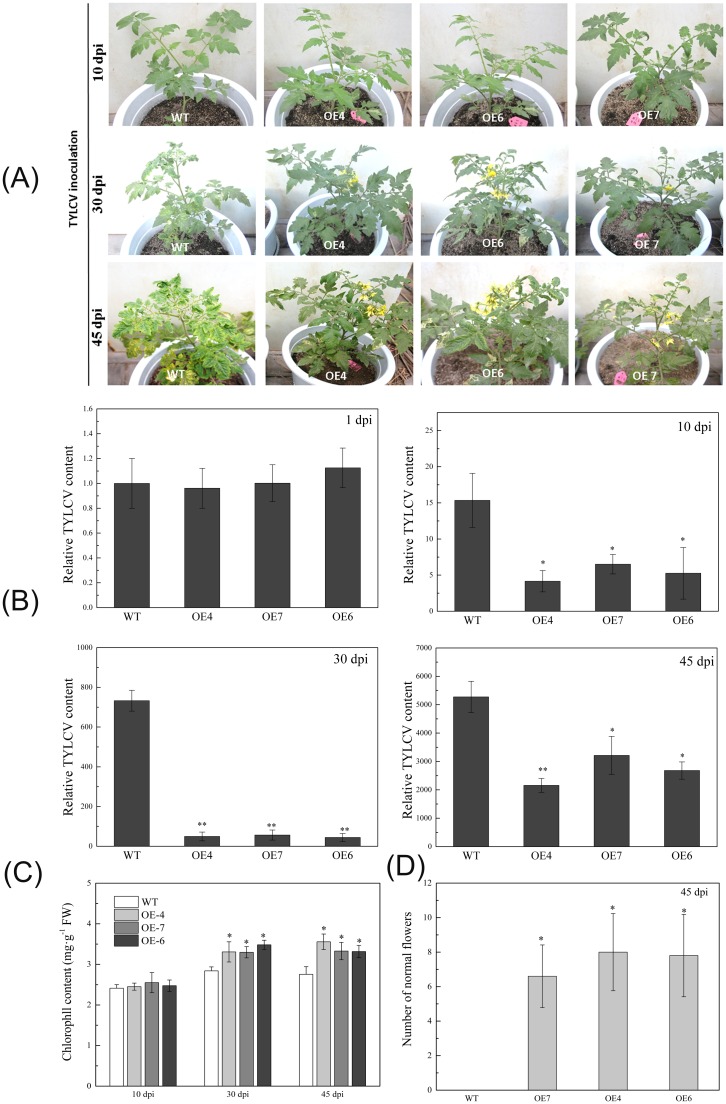
Overexpression of SlMAPK3 in ‘M82’ tomato enhanced tolerance to TYLCV.(A) Phenotype analysis of wild type (WT, ‘M82’) and SlMAPK3-overexpressed (OE-4, OE-6 and OE-7) plants at 10, 30, and 45 dpi with TYLCV. (B) The relative TYLCV content in WT and SlMAPK3-overexpressed lines at 1, 10, 30, and 45 dpi. Values are means ± standard error (SE), replicated thrice. Tomato β-actin was used as an internal control for qRT-PCR [62, 63]. The expression levels are relative to 1 dpi. (C) Leaf chlorophyll contents in WT and SlMAPK3-overexpressed lines. Values in B-D are means ± SE of at least three replicates. (D) The average number of flowers on WT and SlMAPK3-overexpressed plants at 45 dpi. Values are means ± SE of at least three replicates. Significant differences between the OE lines and the WT lines were compared using Tukey’s test. * Significant at P<0.05, ** Significant at P<0.01.